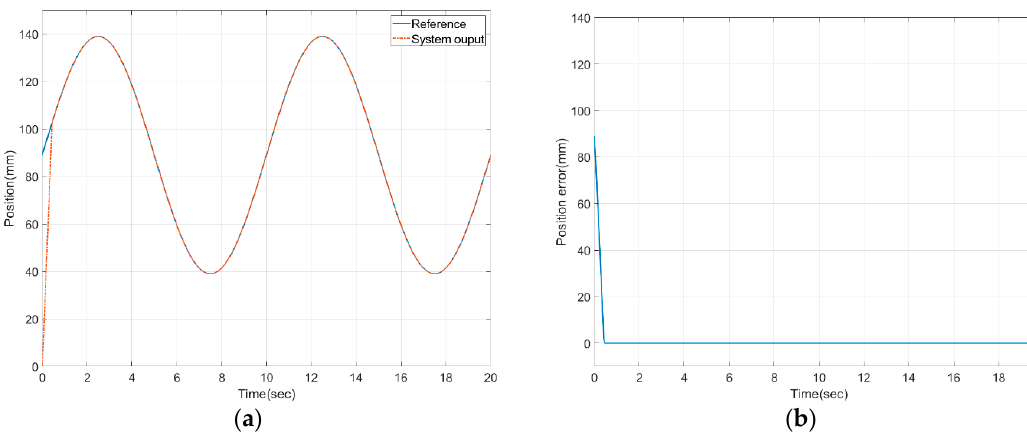
Figure 9. Simulation results of sliding mode control: ( a ) results of position performance in mm; ( b ) tracking error in mm. Table 2. Parameters for electro-hydraulic actuator (EHA) simulation .